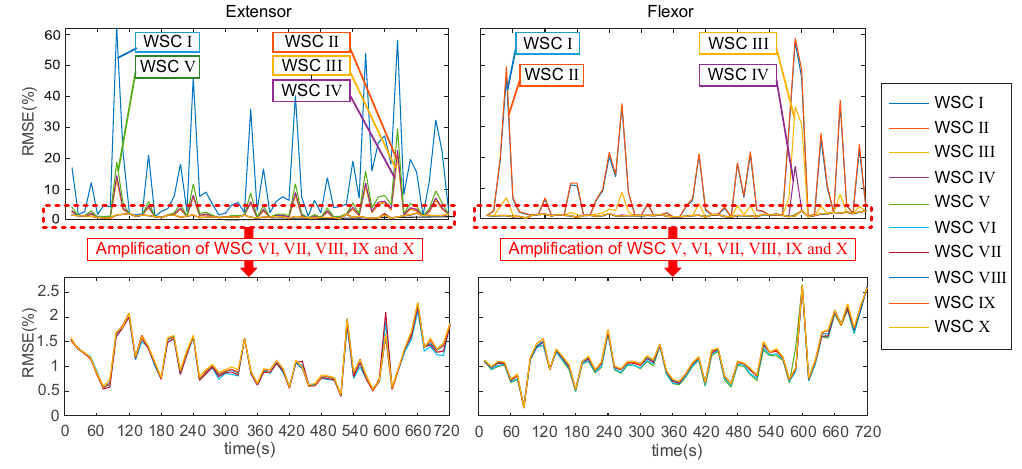
Figure 7. Varying RMSE process of each wavelet scale combination (WSC) in the force-varying validation task.